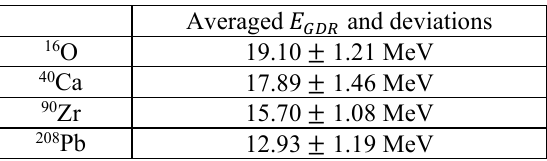
Table 3. Averaged GDR peak energies and standard deviations for 16 O, 40 Ca, 90 Zr, and 208 Pb, obtained by Monte Carlo calculation using randomized SLy5-min parameter sets.